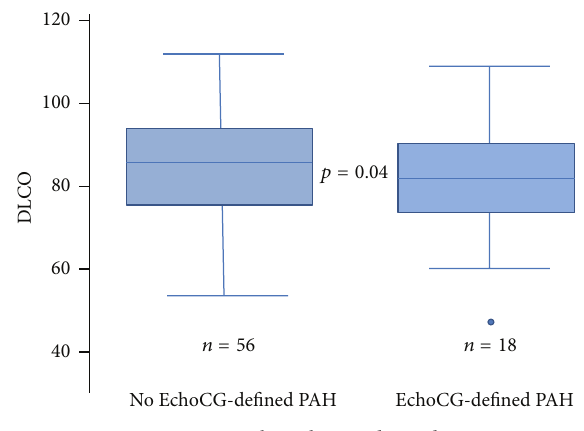
Figure 3: DLCO by EchoCG-derived